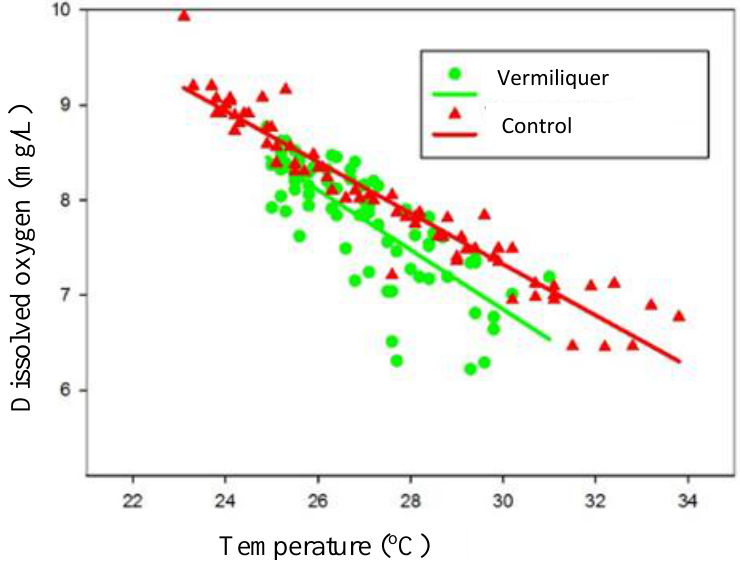
Figure 4. Relationship between dissolved oxygen (DO—mg/L) and nutrient solution temperature (°C) for vermiliquer and control (Boxell inorganic nutrient) sources in Study IV. Regression analysis indicated parallel lines (b = 0.283 ± 0.016), with different intercepts, Vermiliquer: y = 15.44 − 0.283x, Control y = 15.70 − 0.283x, R 2 = 0.680 for combined regressions.